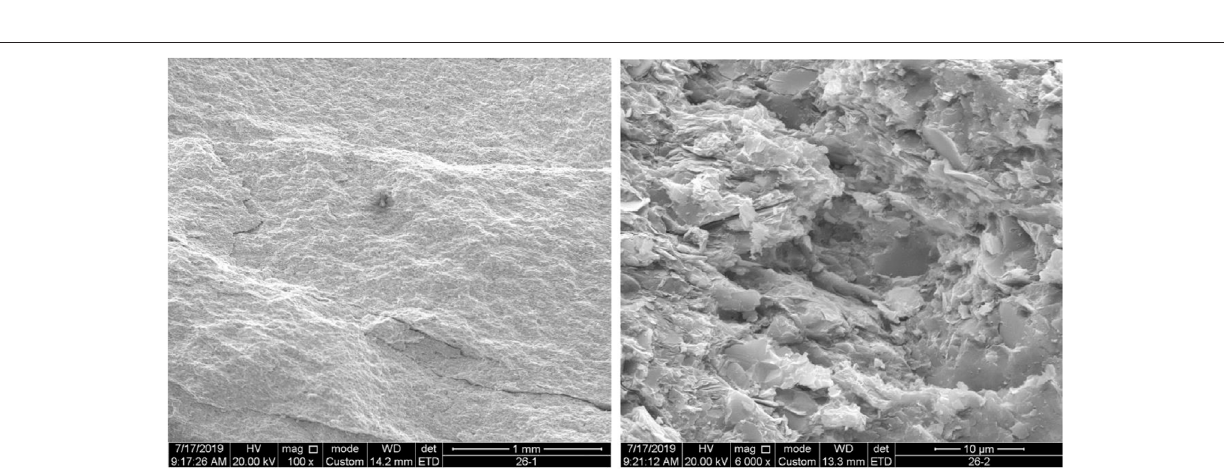
FIGURE 3 | Scanning electron microscope (SEM) images for #15